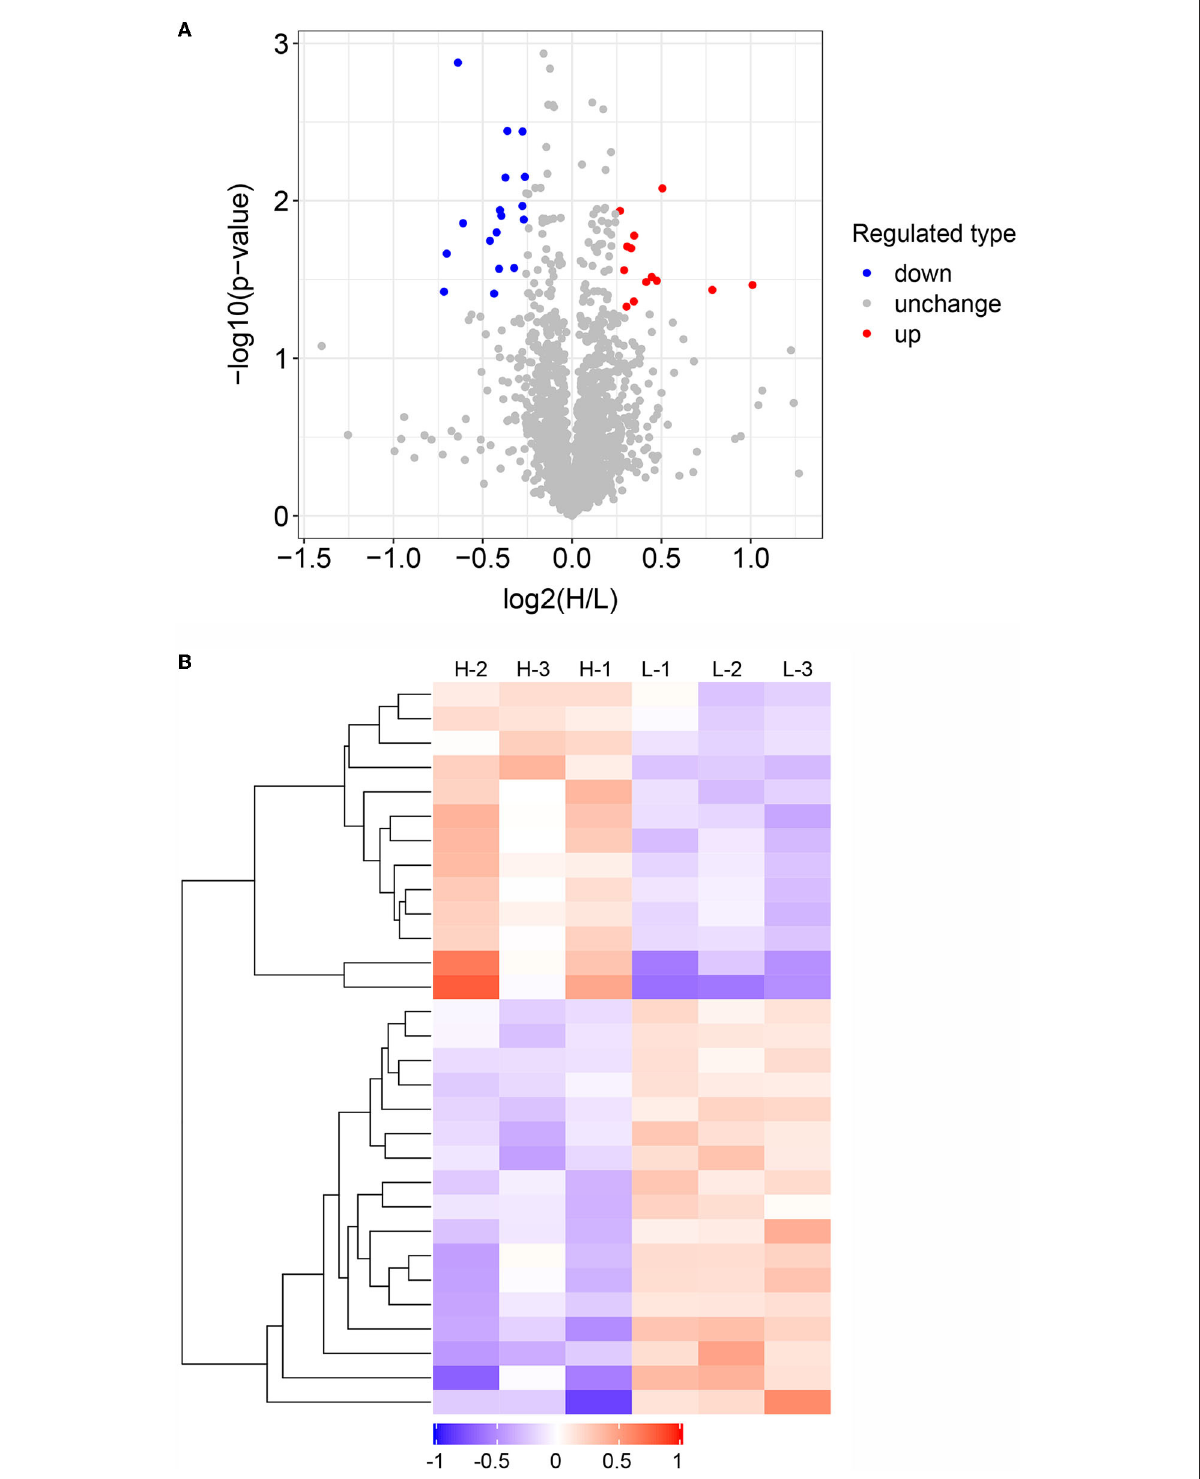
FIGURE3 Analysis of differentially abundant proteins (DAPs) between high and low intramuscular fat (IMF) groups. (A) Volcano plot showing DAPs between high and low IMF groups. Red, gray, and blue dots represent upregulated, unchanged, and downregulated proteins, respectively. (B) Heatmap showing the abundance patterns of the DAPs between the three high and three low IMF